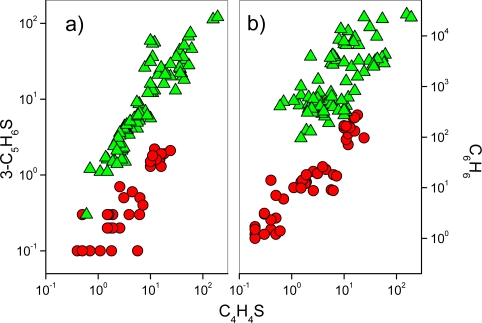
(a) 3-C5H6S vs. C4H4S and (b) C6H6 vs. C4H4S binary diagrams. Symbols as in Figure 2.